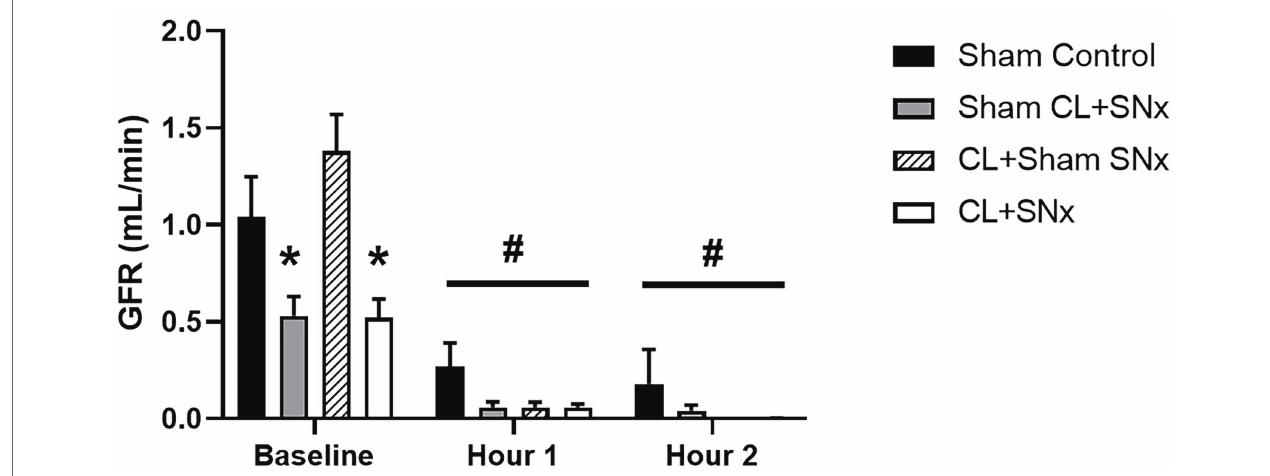
FIGURE 5 | Acute RVP elevation induced a significant reduction of GFR in all experimental groups. Baseline GFR was significantly lower in Sham CL + SN x and CL + SNx groups compared to Control and CL + Sham SN x ; one-way ANOVA, * p < 0.05. Upon RVP elevation, GFR fell significantly from baseline within all groups; one-way RM ANOVA compared to baseline, # p <